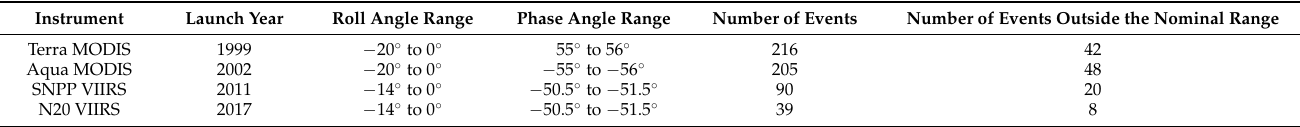
Table 2. Summary of scheduled lunar events for MODIS and VIIRS instruments. The number of events listed is from the beginning of each mission through 1 July